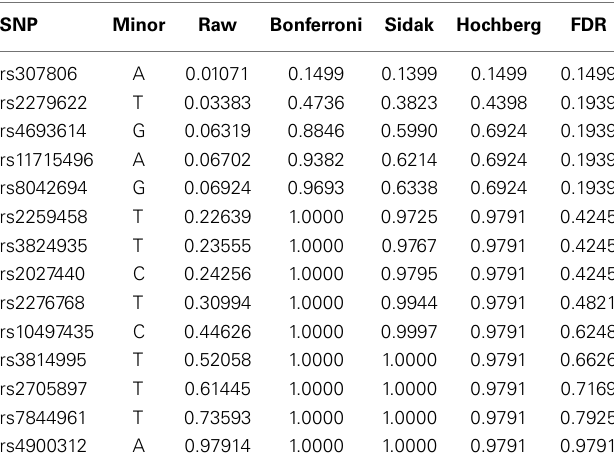
Table 6 | Real data analysis: association between log(GFR) and 14